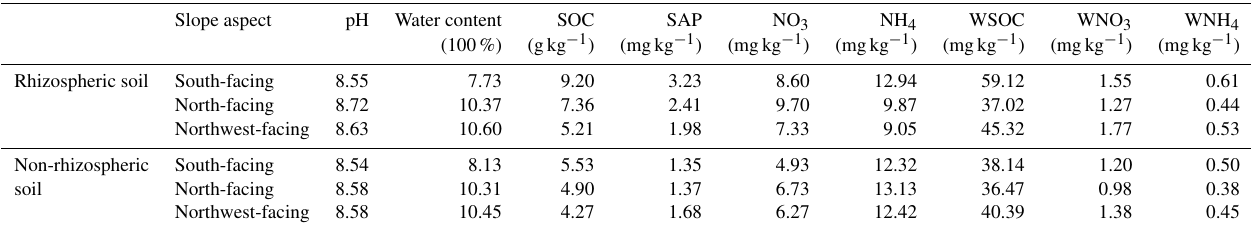
Table 3. Characteristics of the rhizospheric and non-rhizospheric soils. Slope aspect pH Water content SOC SAP NO 3 NH 4 WSOC WNO 3 WNH 4 (100%) (gkg − 1 ) (mgkg − 1 ) (mgkg − 1 ) (mgkg − 1 ) (mgkg − 1 ) (mgkg − 1 ) (mgkg − 1 ) Rhizospheric soil